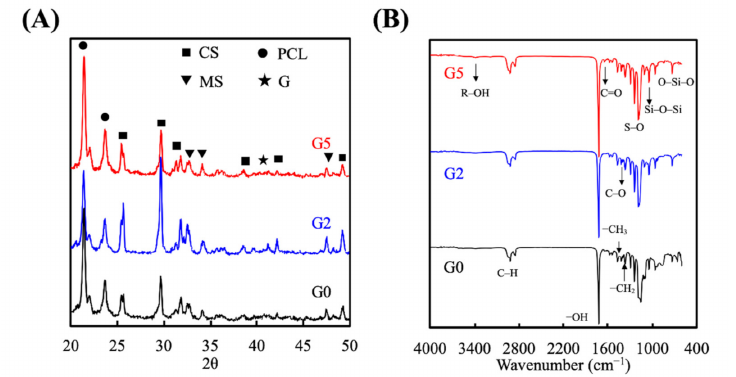
Figure 2. ( A ) X-ray diffractometry and ( B ) Fourier transform infrared spectroscopy results for the GR-contained MSCS